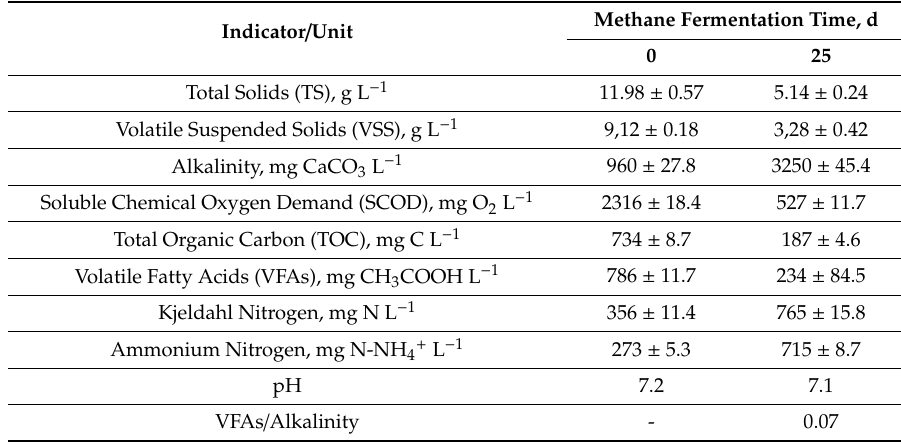
Table 5. Changes of physico-chemical parameters of disintegrated excess sludge with an ultrasonic wave intensity of 4.3 W cm − 2 in a 25-day methane fermentation process.